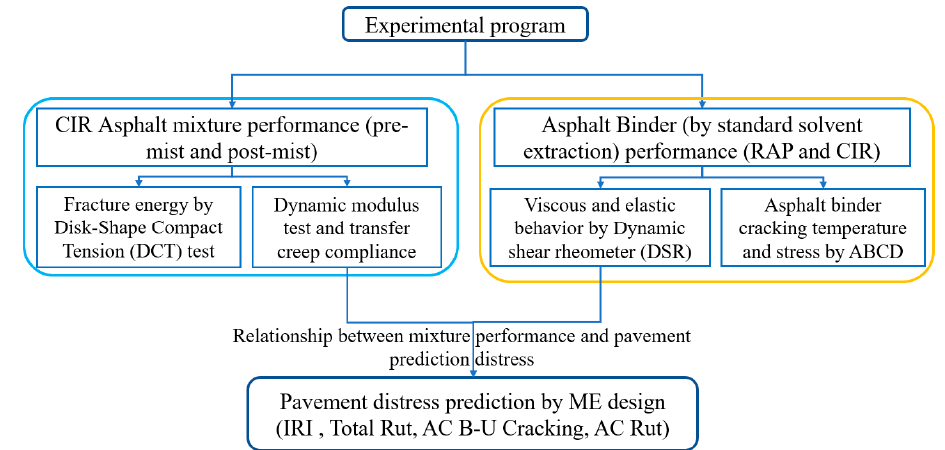
Figure 2. The technical flowchart of this study.